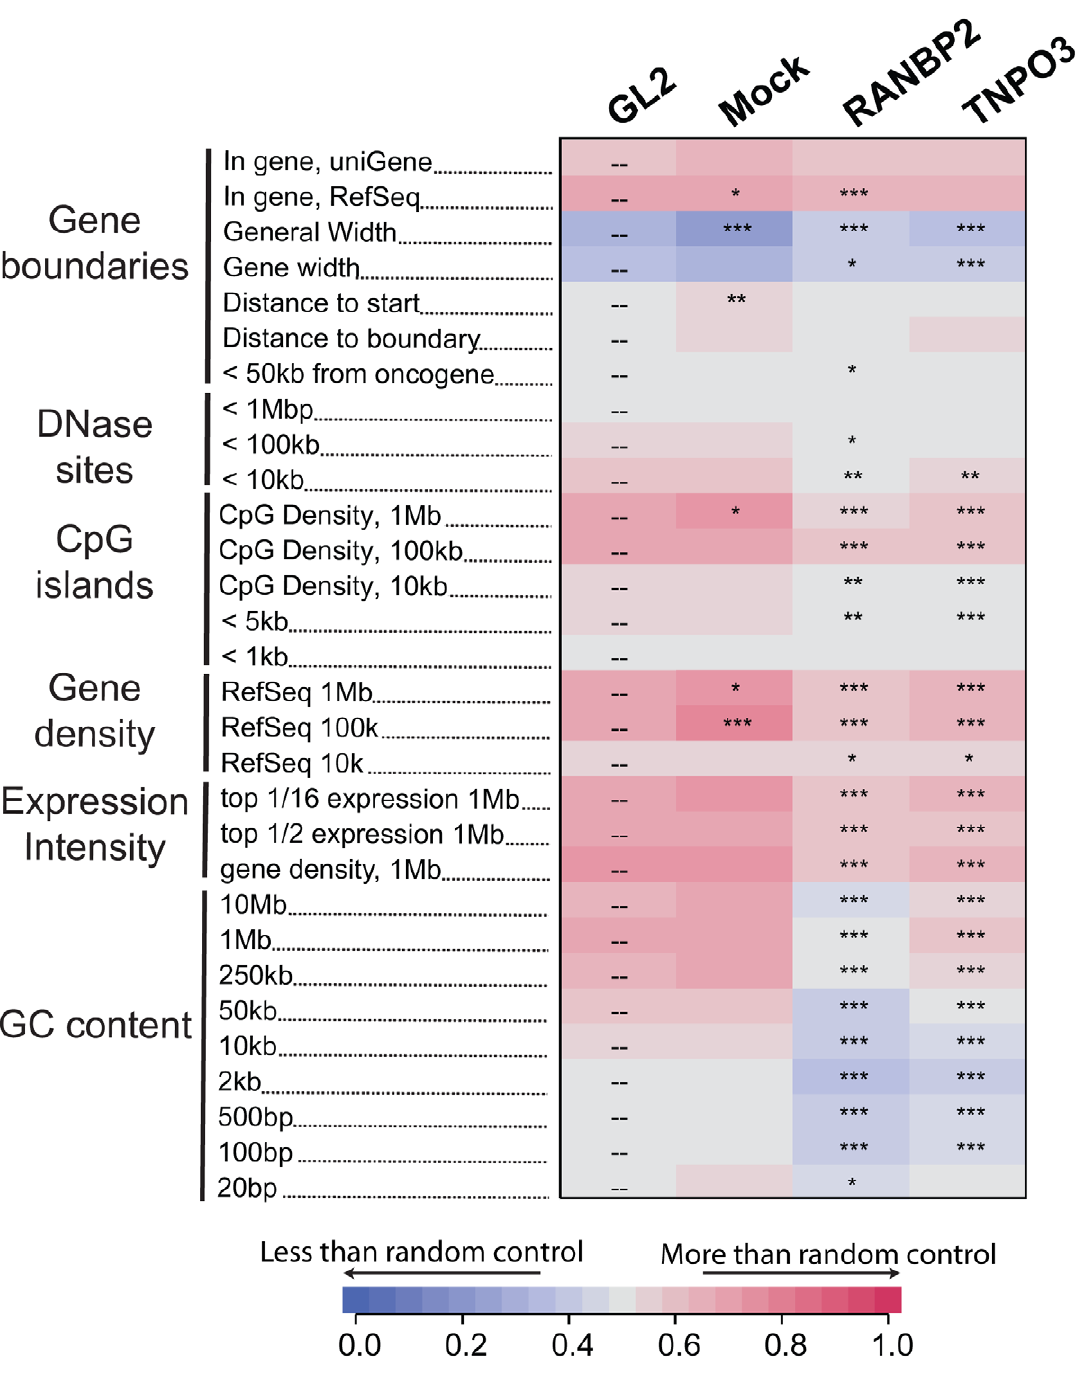
Figure 2. Effects of Transportin-3 and RanBP2 depletion on integration near multiple chromosomal features. Genes targeted by siRNA in infected cells including the control, GL2, are shown above the columns. Mock cells received no siRNA. The genomic features analyzed are shown in the rows and labeled on the left. Relationships between integration frequency and feature density are summarized using ROC curve areas [18], where increasing shades of blue indicate a negative correlation with integration frequency and increasing shades of red indicate a positive correlation with integration frequency relative to matched random control distributions. The control GL2 siRNA set was used for pairwise statistical comparisons (overlay dashes). P values summarizing the significance of the departure from the GL2 control are shown with asterisks (*P , 0.05; **P , 0.01; ***P , 0.001). Note that the asterisks and the heat map summarize different comparisons (to siGL2 and matched random controls, respectively). The base pair values in the row labels indicate the size of the genomic interval used for analysis–often the most appropriate interval is not known, so several different interval sizes are compared. A more detailed guide to the data presented in this figure can be found in Text S1. An interactive version of this figure is available as Figure S5.